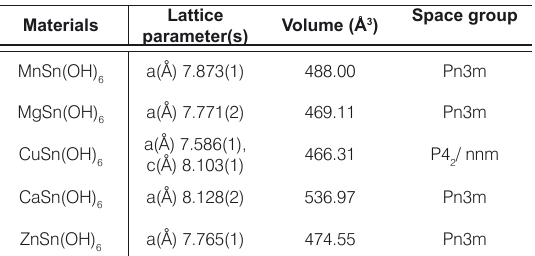
Table 1. Crystal structure details of MSn(OH) Cu, Mg, Mn, and